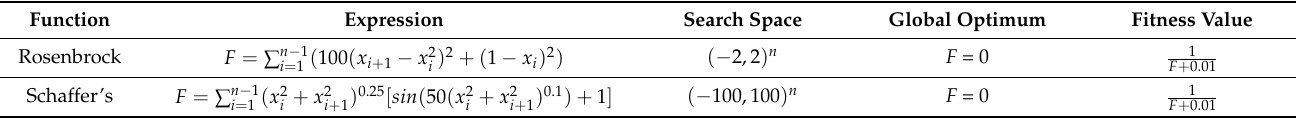
Table 3. Information of new test functions.